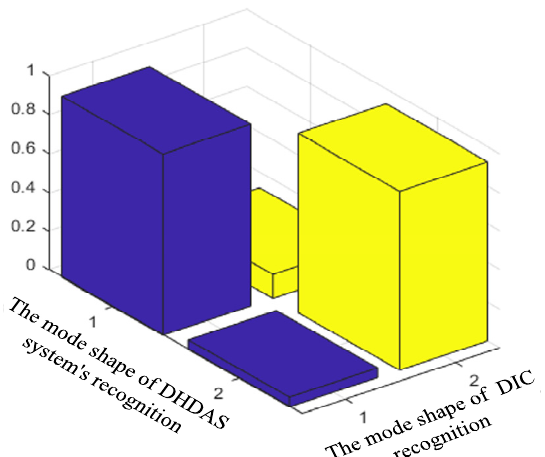
Figure 7. The comparison of the MAC value of the mode shape of DHDAS system’s identification and the mode shape of DIC identification.